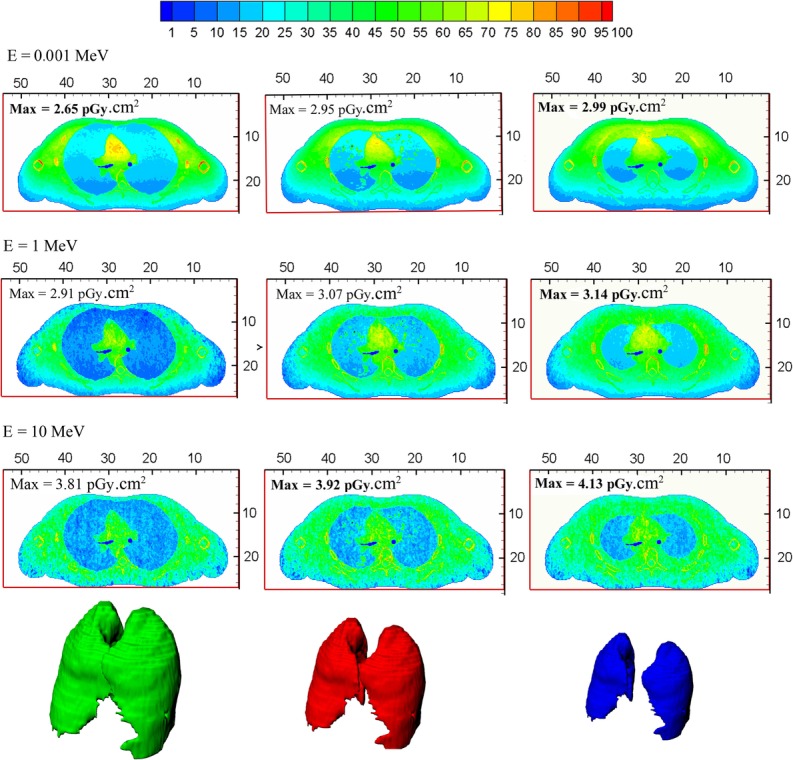
Deposited energy distribution due to secondary photons in anterior–posterior irradiation. Three different neutron energies (0.001, 1 and 10 MeV) are considered here. The plots in the first column belong to the phantom with the largest lung. The third column shows the plots of the phantom into which the smallest lung has been imported. Finally, the middle column corresponds to the ICRP phantom with the normal lung. The lung in each particular row are known to have been irradiated by incident neutrons of similar energy.